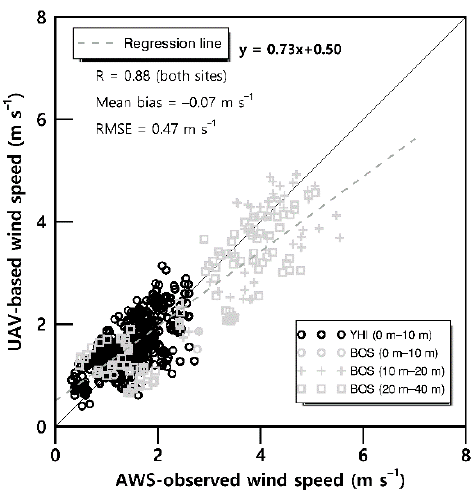
Figure 7. Comparison of UAV-based wind speeds with AWS-observed wind speeds at BOS and YHI.